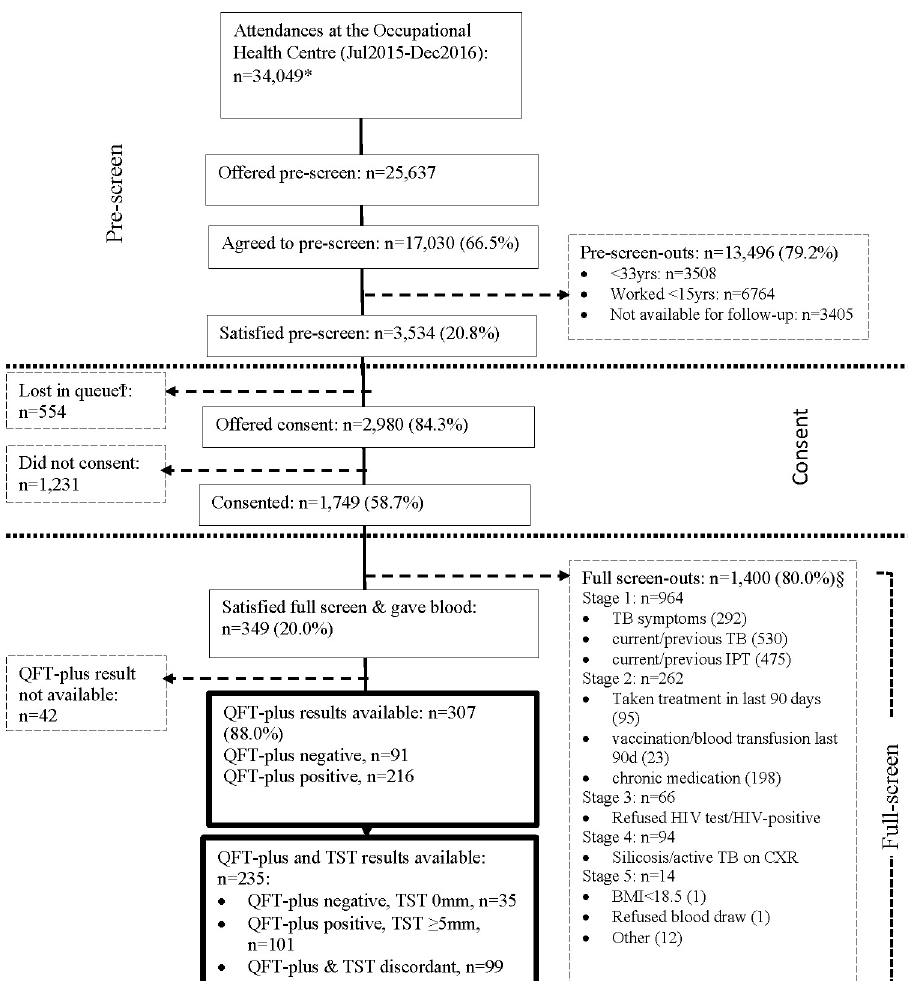
Fig 1. Participant flow. � Data from the daily attendance register. Includes repeat attendances during this time period. §Screen out questions were asked in stages; if screened out at a stage no screening was conducted for subsequent stages. Within a stage more than one screen-out reason may apply. yrs years; IPT isoniazid preventive therapy; BMI body mass index, QFT-plus QuantiFERON-TB Gold-Plus, TST tuberculin skin test. Lost in queue–miners who prescreened for the HETU study while waiting in queue for annual medical examination, but did not make it to the research site for further study related procedures.